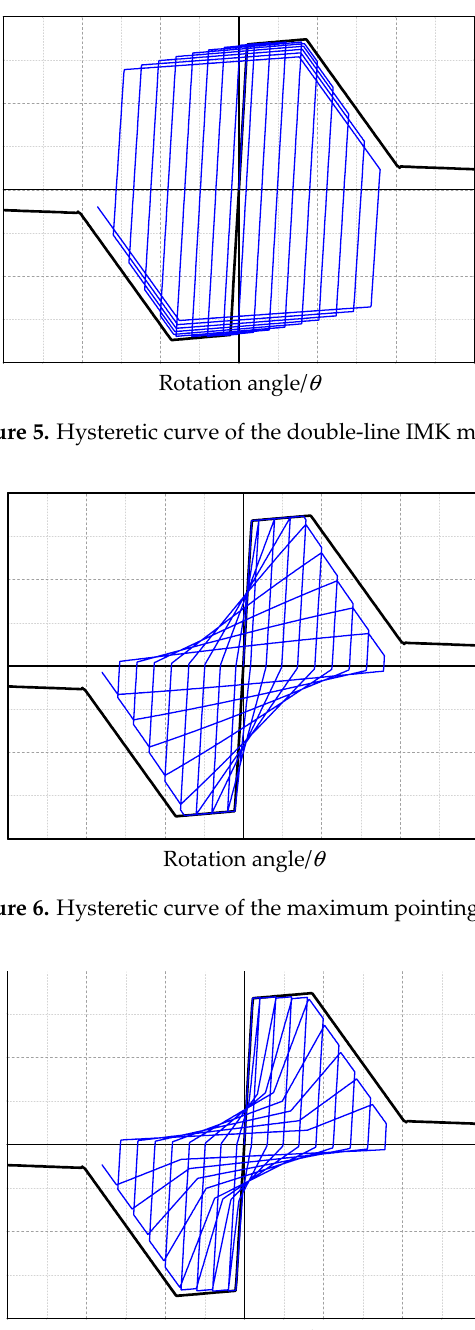
Figure 7. Hysteretic curve of the pinching effect IMK model. The degradation rate of the model is governed by the degradation index β associated with hysteretic energy dissipation. If it is assumed that the hysteretic energy dissipation capacity of the structure is certain and independent of the load path, then, in the i -th